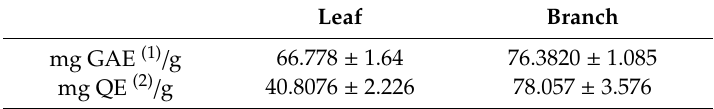
Table 5. Total phenol content and flavonoid content of hot-water extracts from S. samarangense .